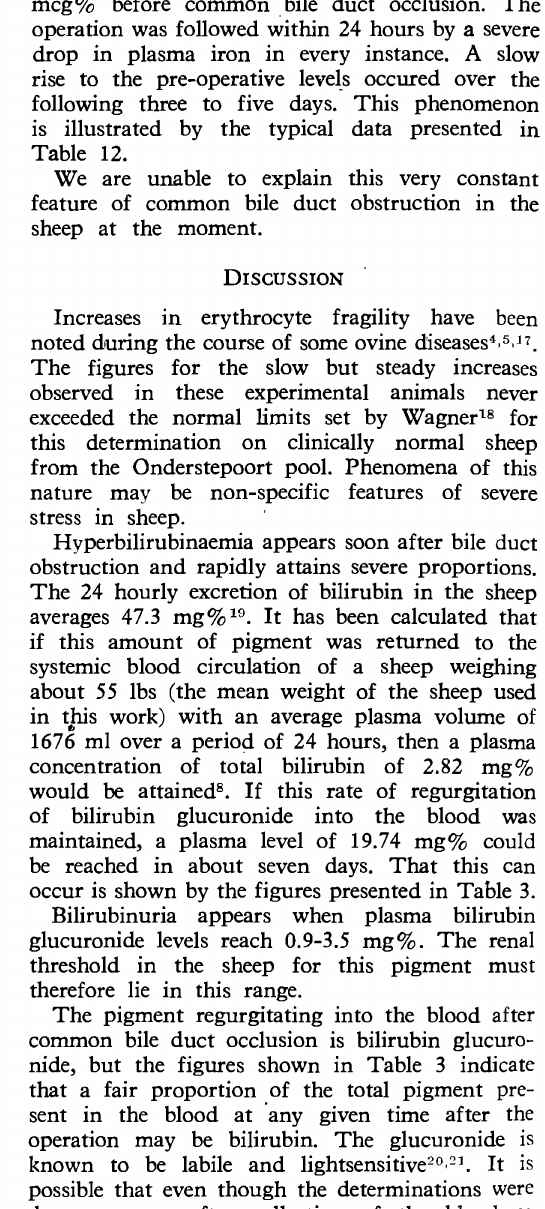
TABLE 12.-PLASMA IRON LEVELS. (All values are mcg%. The first date given for each sheep is the day immediately following the